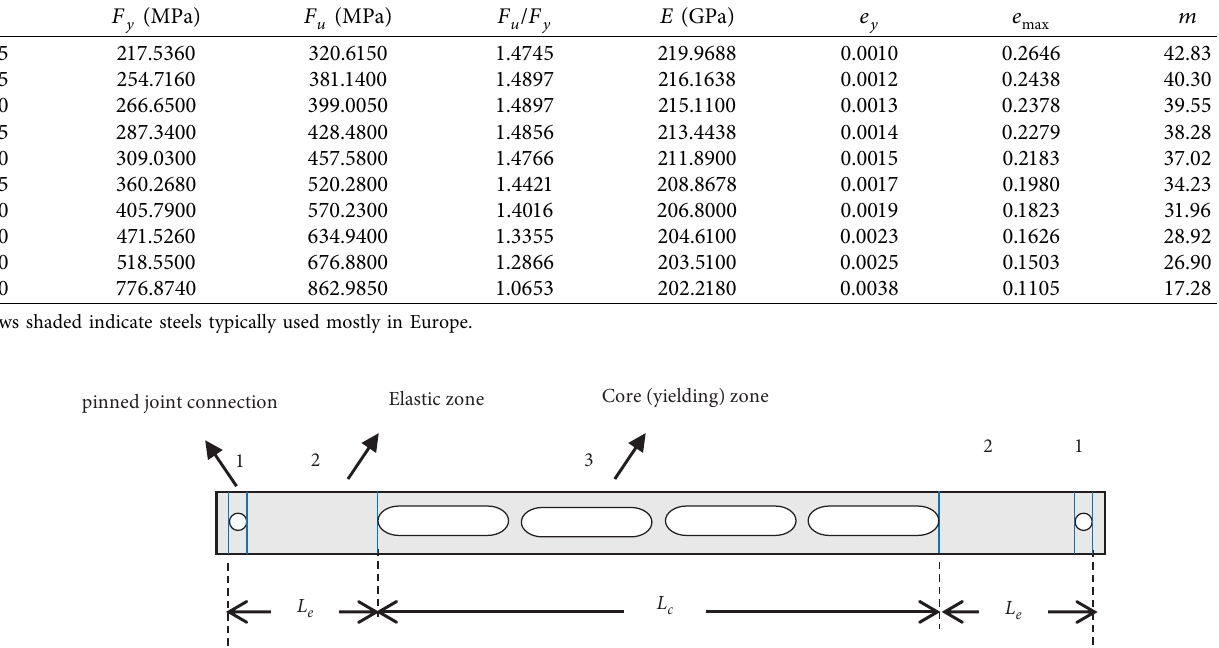
Table 2: Regression values obtained for the steel used for specimens.